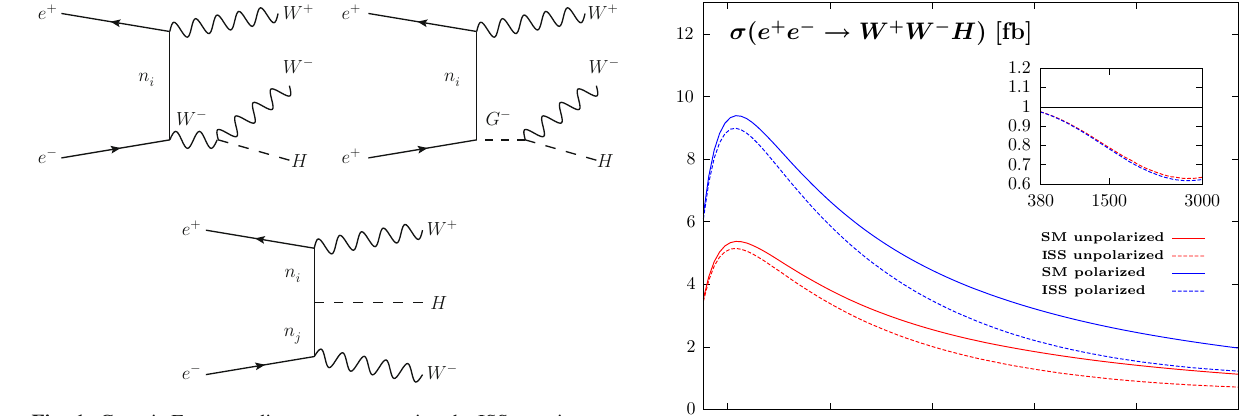
Fig. 1 Generic Feynman diagrams representing the ISS neutrino con- tributions to e + e − → W + W − H in the Feynman-’t Hooft gauge. The indices i , j run from 1 to 9. Mirror diagrams are obtained by flipping all the electric charges Fig. 2 LO total W + W − H production cross-section at an electron-